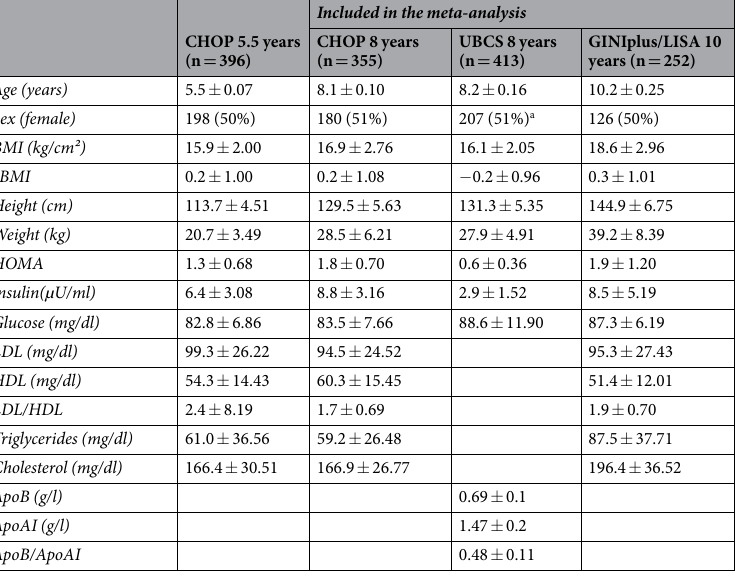
Table 1. Characteristics of the studied populations. Values are presented as mean + / − SD or n (%). a Eleven subjects had no information on